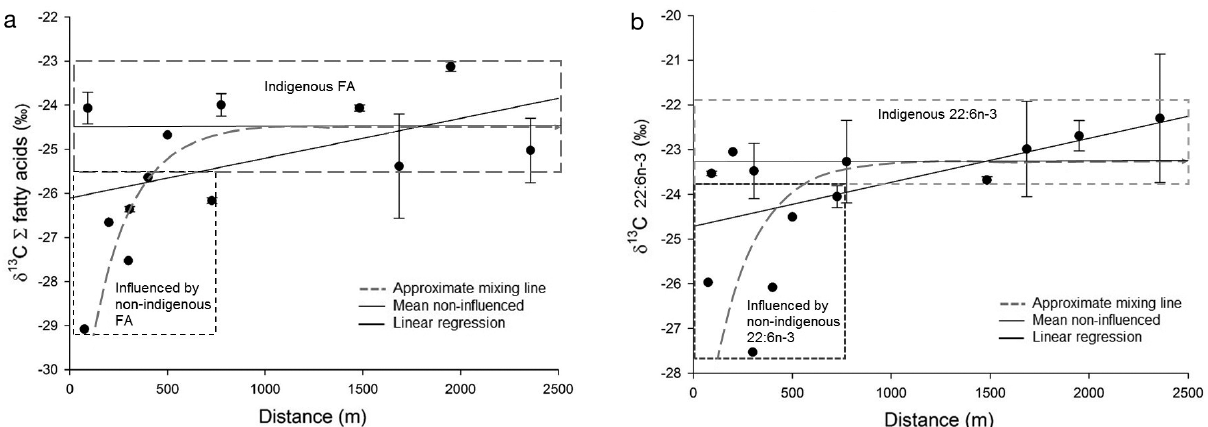
Fig. 1. Isotopic signature (‰) of (a) overall δ 13 C weighted mean, and (b) 22:6n-3 in mussels with increasing distance from salmon cage sites. The plots show mean δ 13 C (± standard deviation) as linear functions with regression analyses performed on raw data. Dashed-box zones highlight observed bimodal scenarios in δ 13 C between distal and proximal locations, with an approximate mixing line estimated as the bimodal connection between endmember δ 13